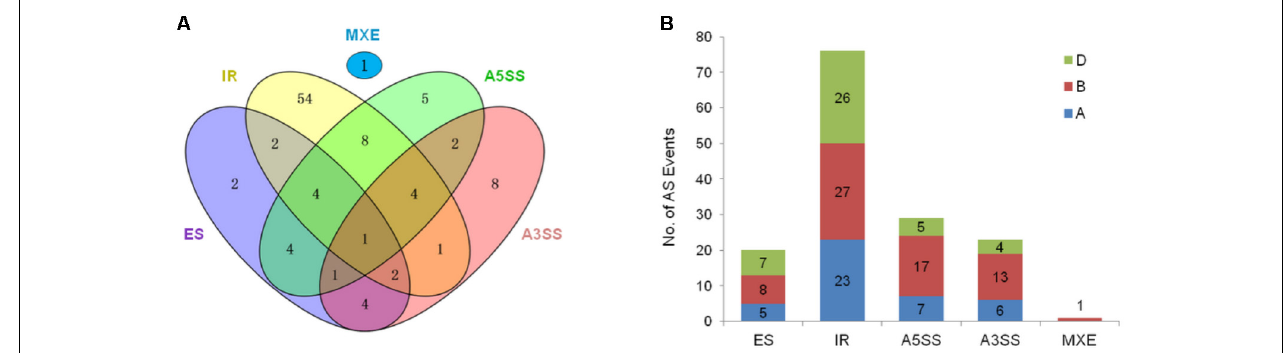
FIGURE 2 | Summary of AS in TaARFs. (A) Five types of AS in 103 splice variants from TaARF homeoalleles. The number of splice variants is represented in each intersection of the Venn diagram. IR, intron retention; ES, exon skipping; A5SS, alternative 5 (cid:48) splicing site; A3SS, alternative 3 (cid:48) splicing site; MXE, mutually